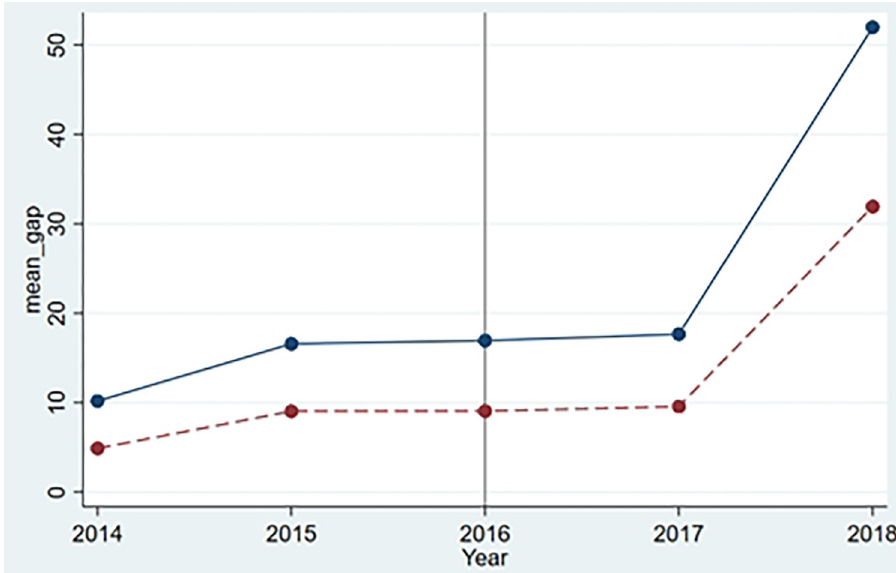
Fig 2. Parallel trend test. Source: Drawn from stata 16.